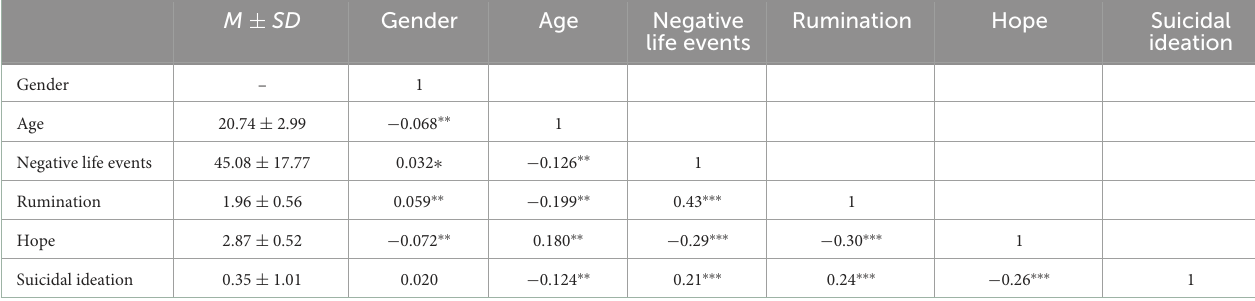
TABLE 3 Descriptive statistics and correlations between variables. M ± SD Gender Age Negative